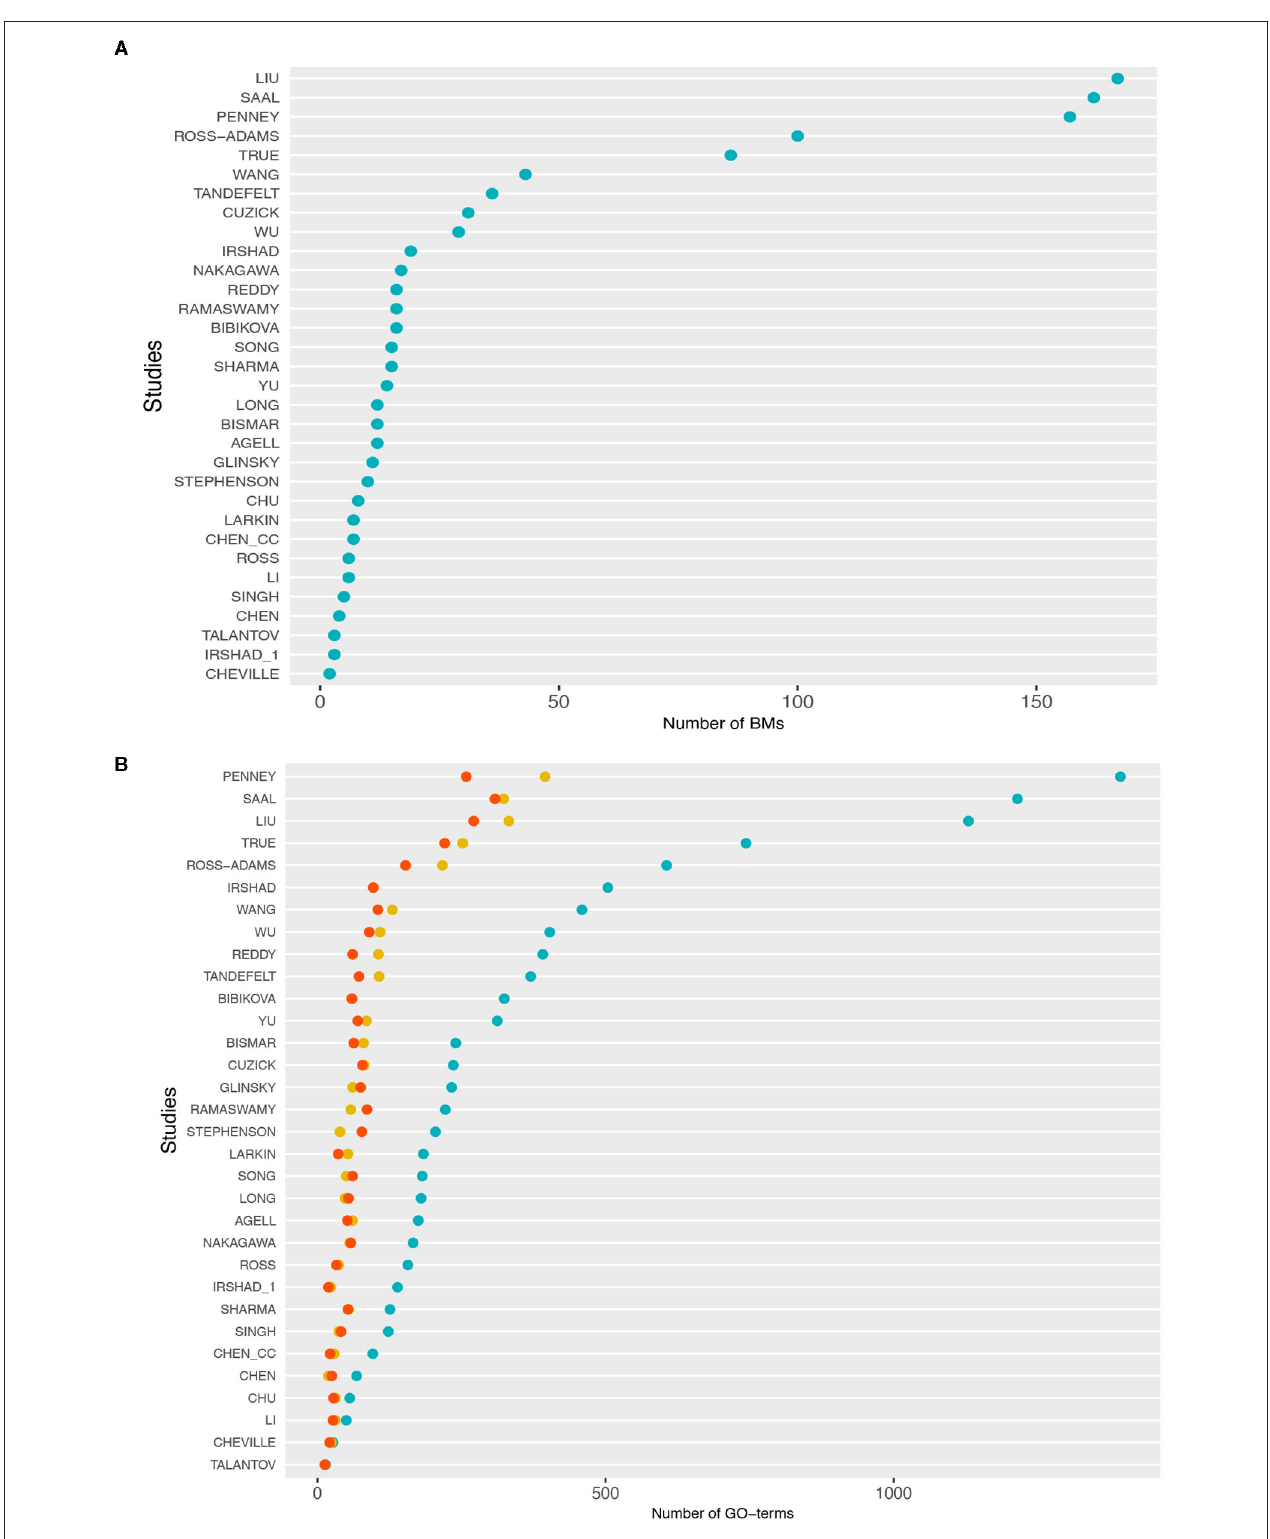
FIGURE 1 | (A) Distributions of the number of biomarker genes in each study. (B) Number of gene ontology (GO)-terms associated with the signature genes in each study. The cyan points correspond to BP, the red points to molecular function (MF), and yellow points to cellular component (CC).